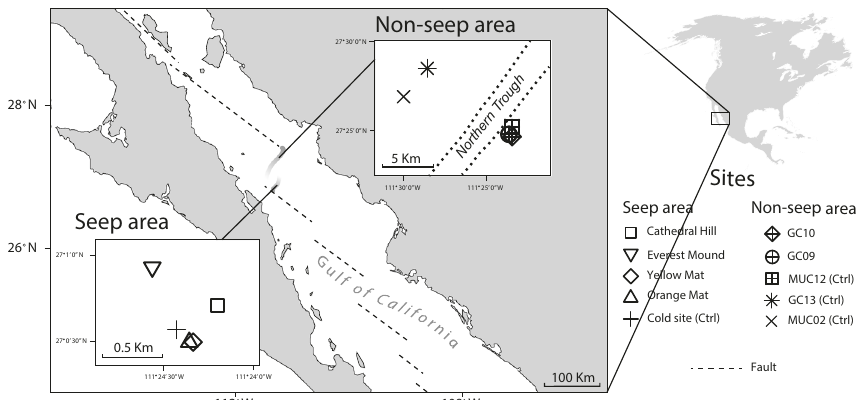
Fig. 7 Map of study area locations within Guaymas Basin, Gulf of California. Dashed lines indicate the transform fault, the troughs near both study areas are shown in shaded gray. The much smaller SA was located entirely within the southern Trough. For high-quality sea fl oor photographs, which were only obtained for the SA and Cold site, we refer to ref. 53 . Map redrawn from